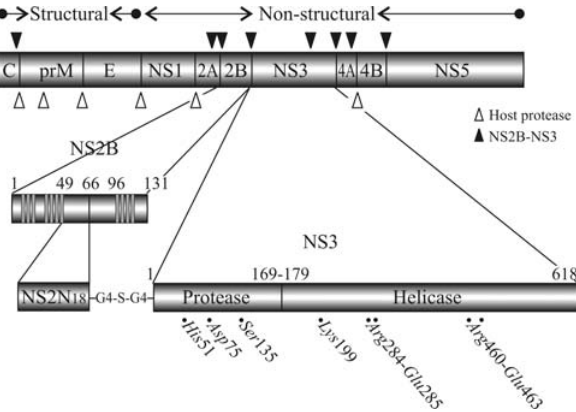
Figure 1 - Schematic representation of the flaviviviral polyprotein with the cleavage sites processed by NS2B-NS3pro indicated by arrows. Also shown is the partition of the various functional domains along the primary sequence of NS2B-NS3. The regions of the NS2B proteins expected to as- sociate with membranes are indicated as filled boxes. Evolutionarily con- served residues essential for NS3 enzymatic activities are